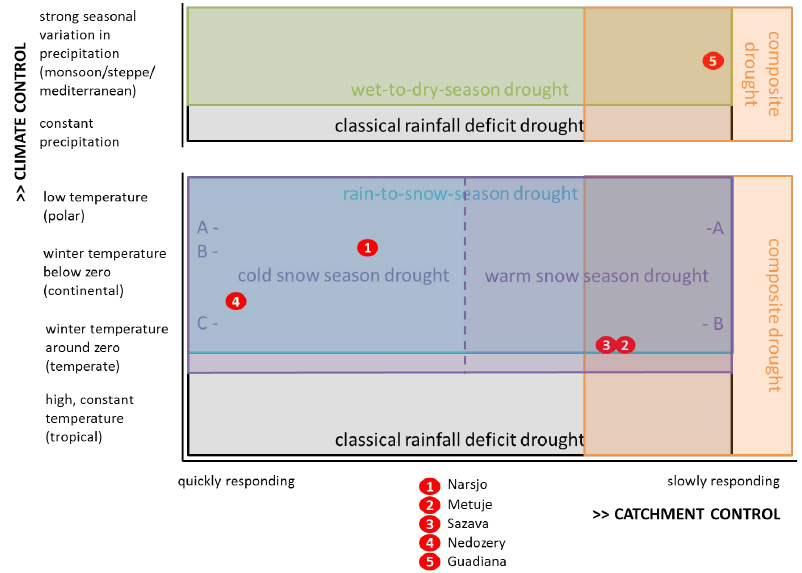
Fig. 14. Hydrological drought (sub-)type occurrence in relation to catchment and climate control. Catchment control is indicated by a slower response of discharge to precipitation when moving from left to right on the x-axis. Climate control is indicated by describing temperature and precipitation regimes relevant for drought development: temperature on the lower part of the y-axis, precipitation on the upper part of the y-axis (desert and glacier climates are not included, as is it not relevant to speak of droughts in these climates, WMO, 2008). The five study catchments are included based on their climate and catchment characteristics (see Sect. 2); for explanation of the drought (sub-)types see Table